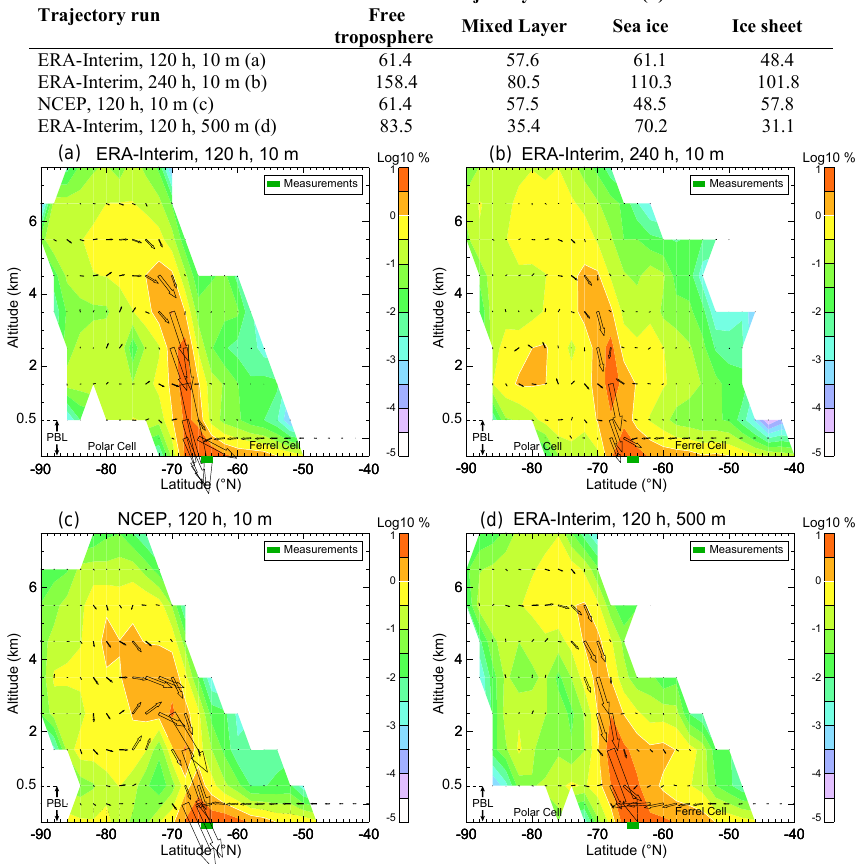
Figure A4. Assessment of reliability of trajectory analyses in the Antarctic region. (a) Longitudinally averaged cross section showing grid frequency of five day back trajectories using ERA-Interim reanalysis, released at 10ma . s . l . for every hour of the voyage, with two- dimensional vectors weighted by the number of points at each location. (b) As in (a) , but for 10-day trajectories. (c) As in (a) , but using NCEP reanalysis. Analyses with GDAS reanalysis produced patterns similar to ERA-Interim. (d) As in (a) , but using a starting point of 500m. Varying any of these parameters creates minimal changes in final trajectories, giving confidence in the conclusions of circulation. The table above outlines average contact time with various aspects of the atmosphere and surface. Note that the sum of the free troposphere and mixed layer contact times does not equal the total time due to necessary data removal and